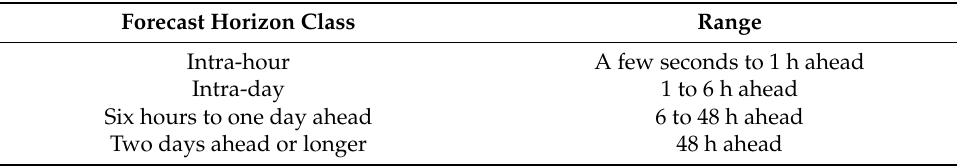
Table 1. Classification of solar forecasting based on temporal